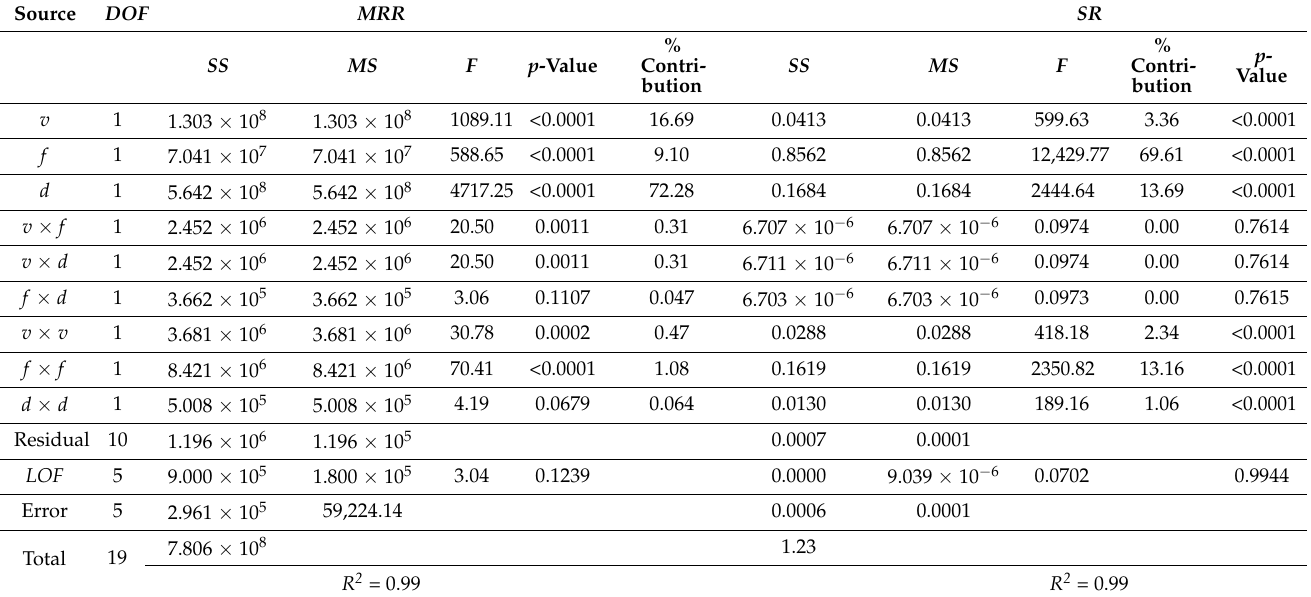
Table 5. ANOVA results for MRR and SR